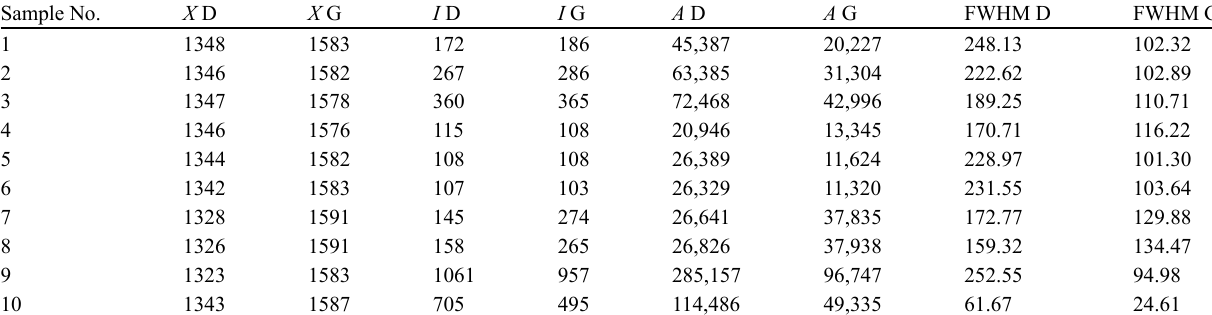
Table 6 Fitting parameters of coals “D” and “G” bands on basis of raw Raman spectra Sample No.